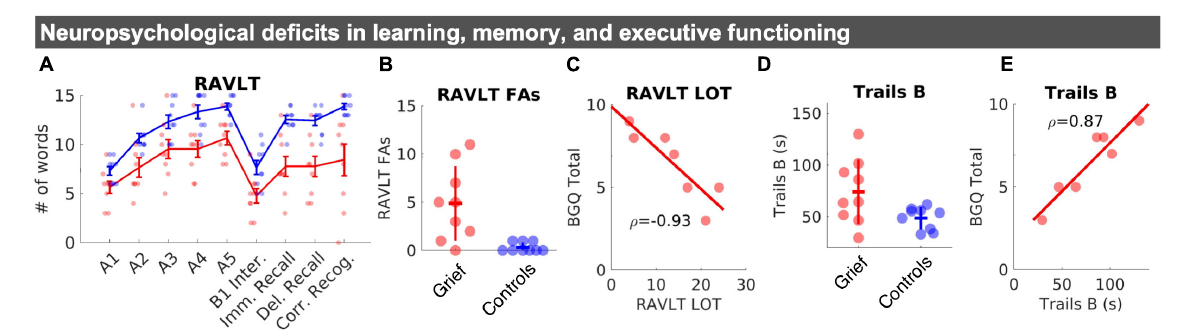
FIGURE2 Neuropsychological changes in learning, memory, and executive functioning. (A) Mean RAVLT word list scores by group: Learning trials (A1–A5), interference list (B1), immediate and delayed recall, and corrected recognition (# of correct hits–# of incorrect false alarms). Standard error bars and individual datapoints are shown. (B) Individual datapoints for RAVLT false alarms shown with SD crossbars. (C) Correlation between BGQ and learning efficiency (LOT index five Total of trials (I to V)–(5X [A1])). (D) Individual datapoints for Trails B shown with SD crossbars. (E) Correlation between Trails B performance, in seconds, and subjective grief on the BGQ. RAVLT, rey auditory verbal learning test; FAs, false alarms; LOT, learning over trials.